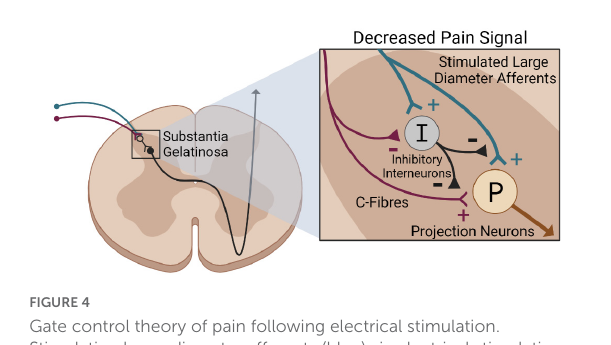
FIGURE4 Gate control theory of pain following electrical